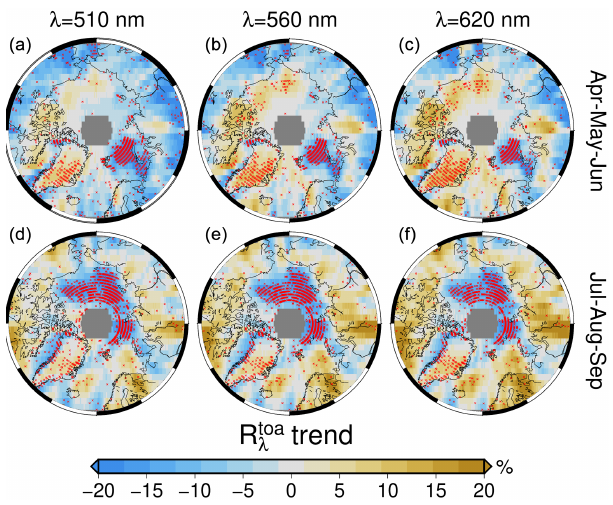
Figure 6. Seasonal R TOA λ trends for 1996–2018 at selected λ for Arctic spring (AMJ, a–c ) and summer (JAS, d–f ). The values are relative to the leading season of the record. Stippling in red indicates significant trends at 95%